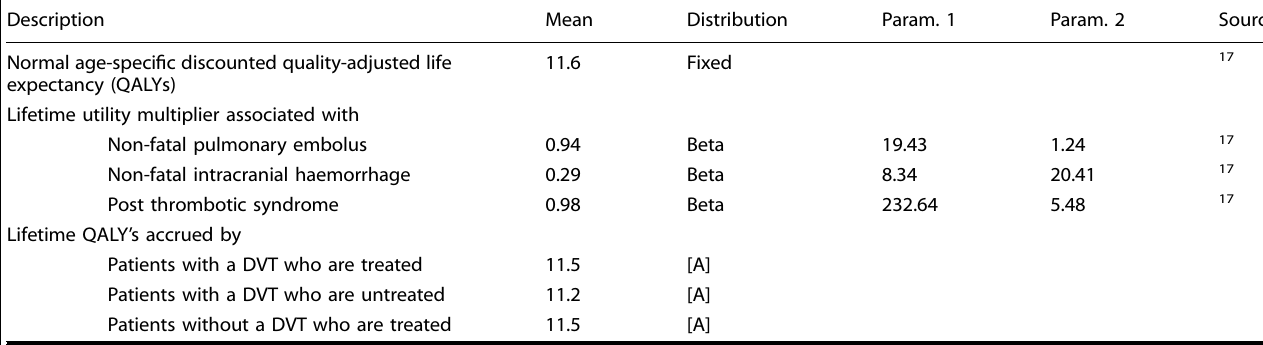
Table 13. QALYs associated with outcomes and QALYs accrued by patient category.